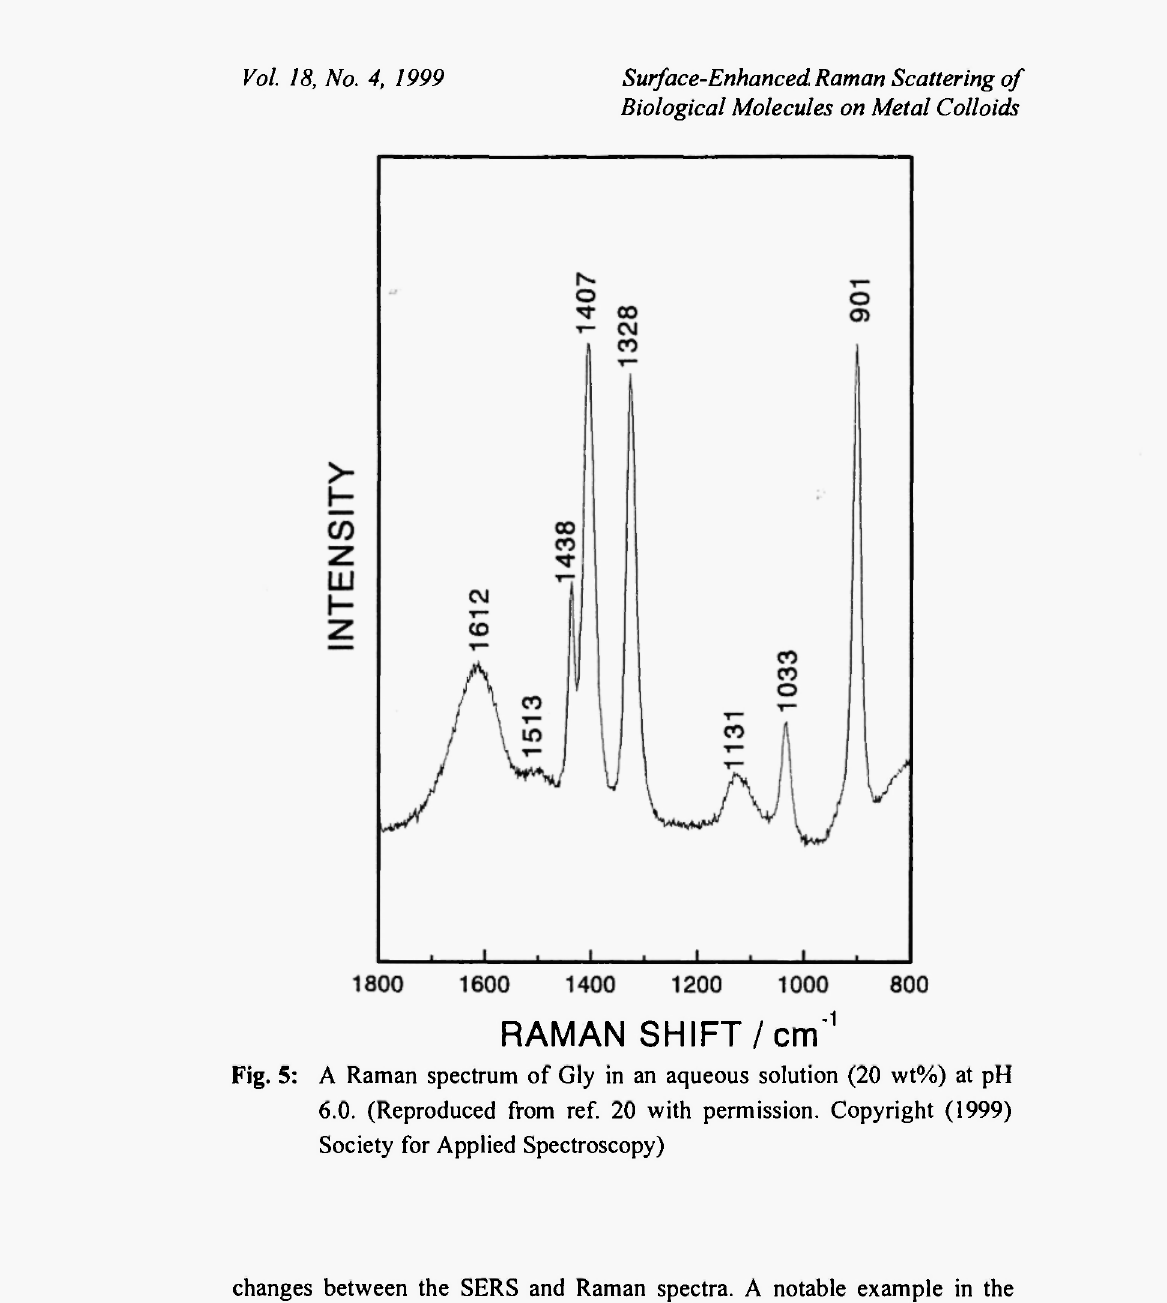
Fig. 5: A Raman spectrum of Gly in an aqueous solution (20 wt%) at pH 6.0. (Reproduced from ref. 20 with permission. Copyright (1999) Society for Applied